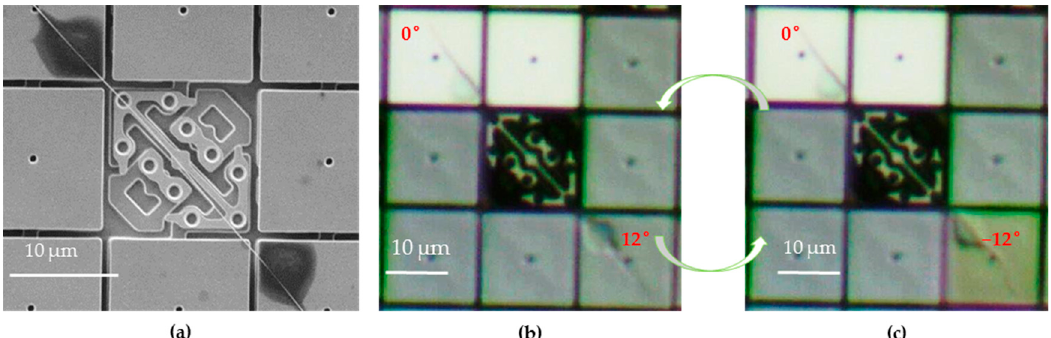
Figure 4. Cyclic torsional loading on a nanowire with twisting angle of 12°: ( a ) shows the SEM image of the 100 nm nanowire sample after the test. The lower right mirror flipped to 12° in ( b ) then quickly flipped to − 12° in ( c ). Repeating the processes of (b) and (c) alternatively will induce the cyclic torsion loading on the nanowire sample.